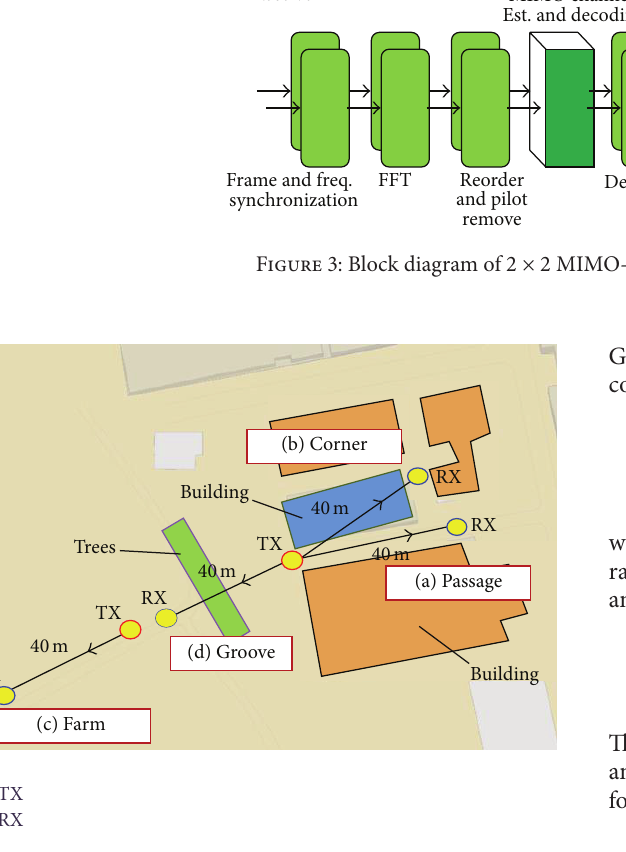
Figure 4: Experimental place for passage, corner, farm, and groove conditions in Hokkaido University Sapporo